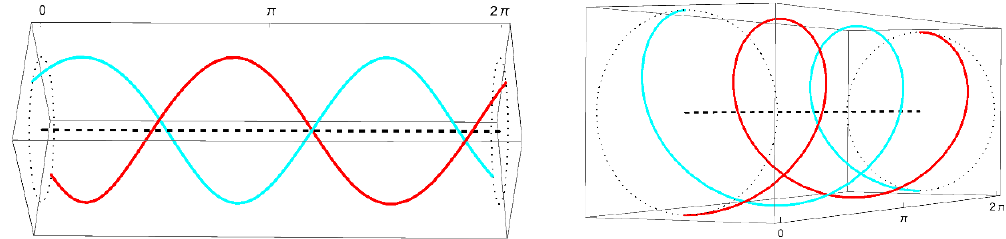
Figure 7. A visualization of the g -tube for ( a; b ) = (1 ; 1) as (cid:18) z is varied from 0 to 2 (cid:25) . The dashed line represents the path traveled by the base point p at the center D t (0). The strands are seven-branes and the color coding matches that of (cid:12)gure 6a.